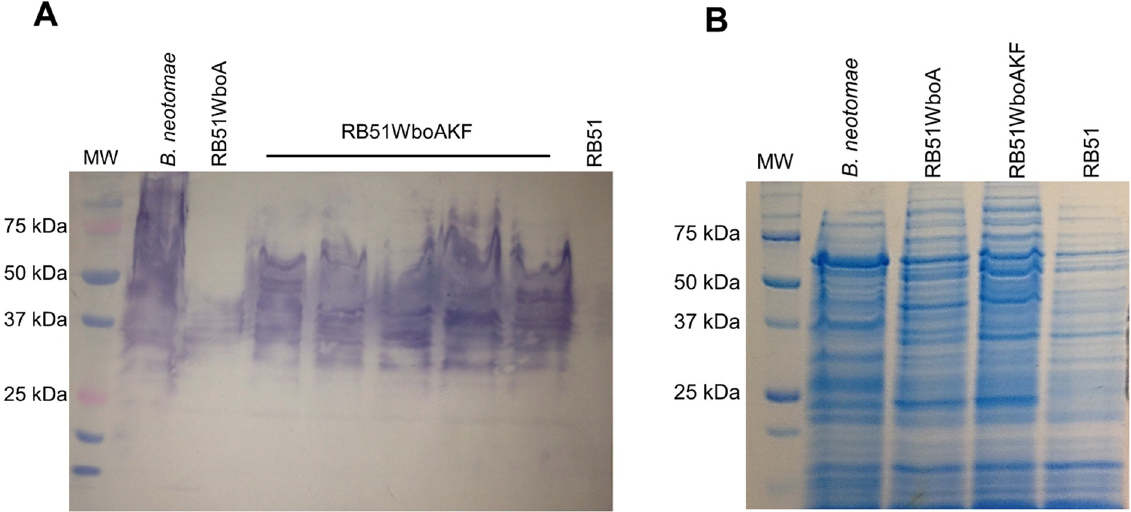
Fig 1. Overexpression of wbkF in strain RB51WboA results in O-polysaccharide expression. Whole bacterial antigens were separated by SDS-PAGE and analyzed by (A) Western blotting with O-polysaccharide specific monoclonal antibody, Bru-38, and (B) Coomassie Brilliant Blue staining of the polyacrylamide gel to detect any differences in the expressed protein profiles.